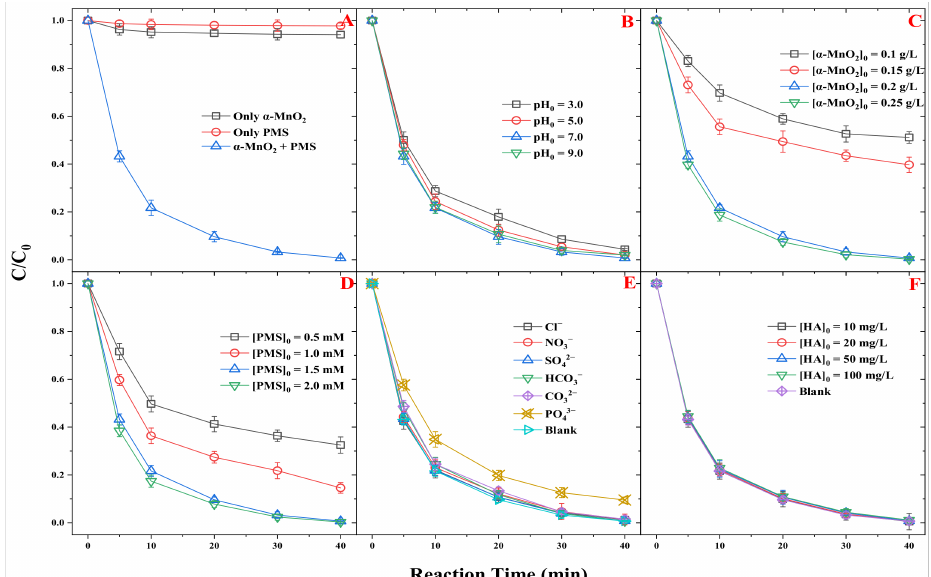
Figure 1. Removal of phenol by only α -MnO 2 , only PMS or α -MnO 2 /PMS system ( A ), effects of pH ( B ), α -MnO 2 dosage ( C ), PMS dosage ( D ), common anions ( E ) and HA concentration ( F ) on phenol removal by α -MnO 2 /PMS system. Reaction conditions: [ α -MnO 2 ] 0 = 0.2 g/L, [PMS] 0 = 1.5 mM, [phenol] 0 = 20 mg/L, pH 0 = 7.0, Temperature = 30 ◦ C, [anions] 0 = 5.0